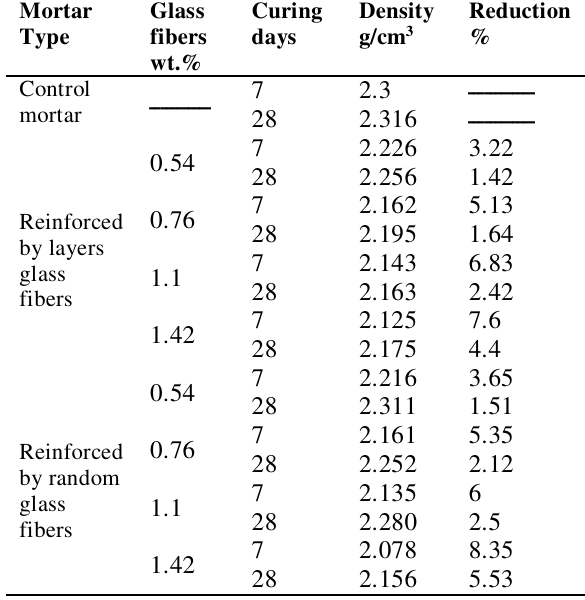
Results of density testing for glass fibers reinforced mortar with